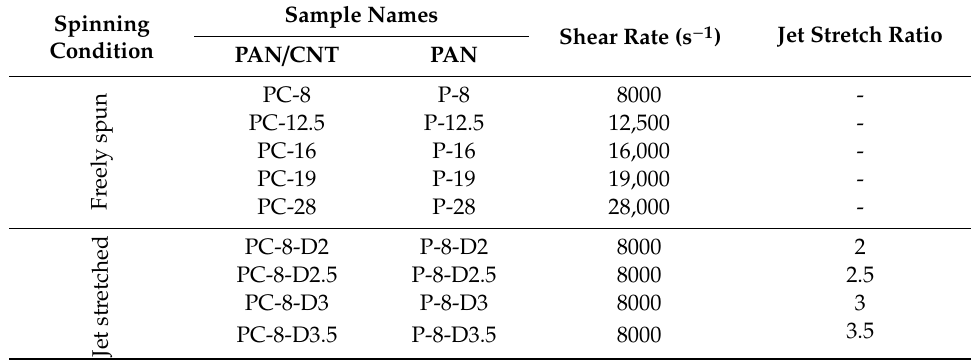
Table 1. Denotation and production conditions of polyacrylonitrile (PAN) and PAN / carbon nanotube (CNT)